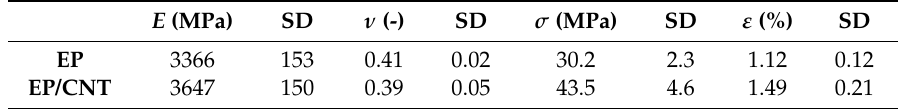
Table 1. Results from tensile tests of neat epoxy (EP) and CNT/epoxy nanocomposites, containing 0.5 wt% oxidized MWCNT (EP/CNT). Mean values are given together with the standard deviation (SD).